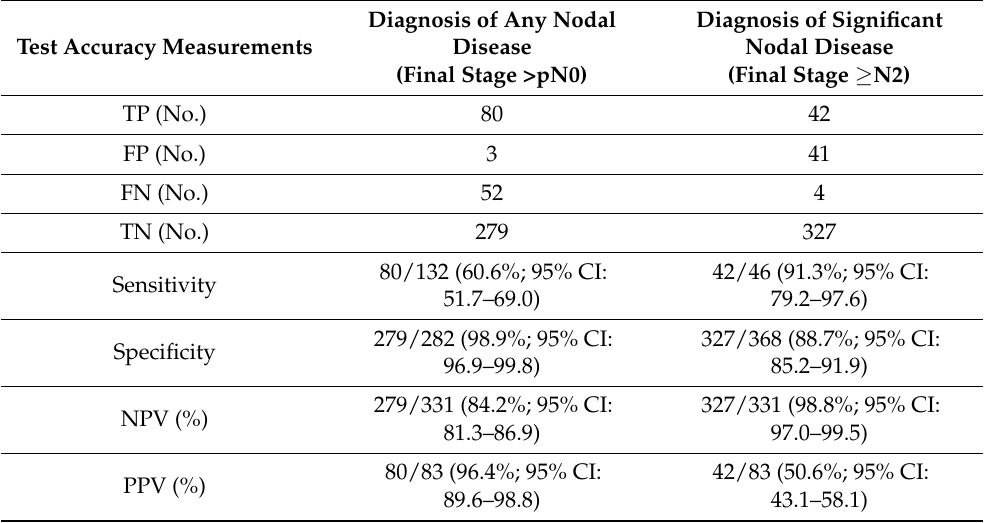
Table 3. Diagnostic indices. TP = true positives, FP = false positives, FN = false negatives, TN = true negatives, PPV = positive predictive value, NPV = negative predictive value, No = number of